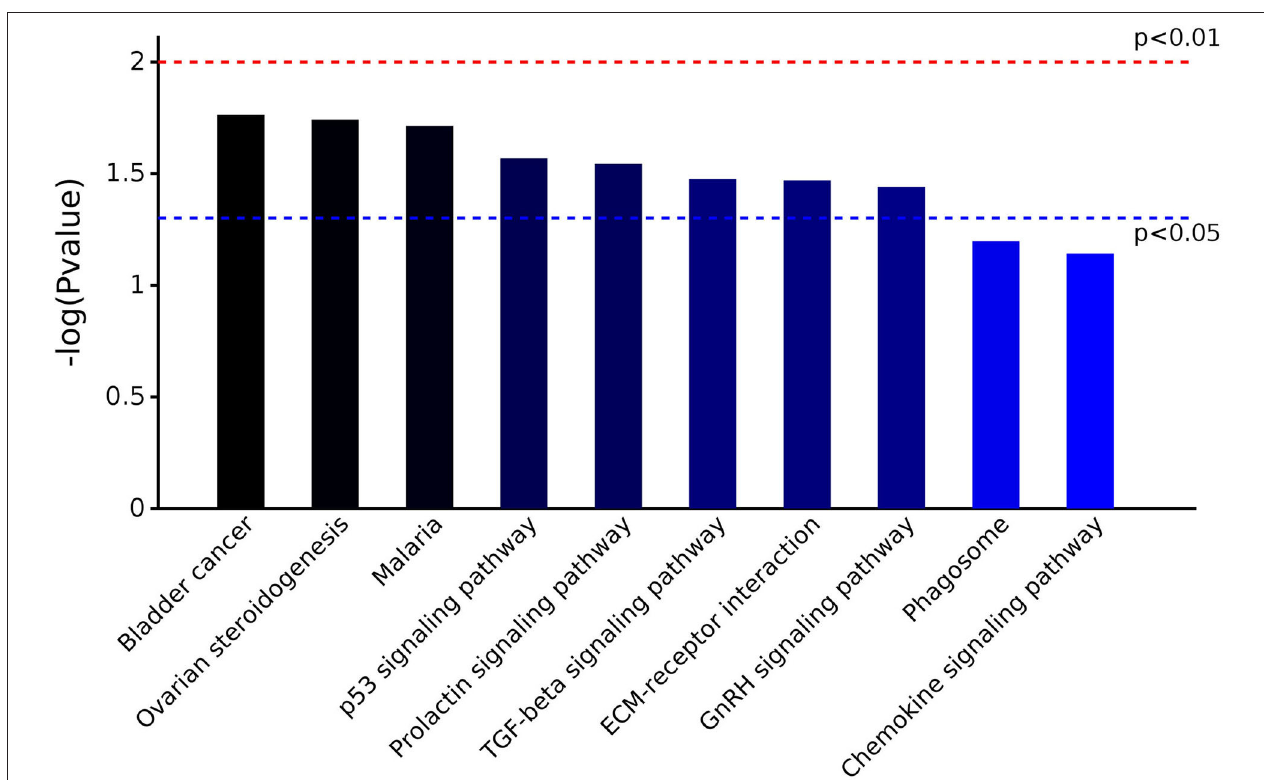
FIGURE 4 | KEGG pathway enrichment analysis of DEPs identified in the serum of early pregnant and non-pregnant jennies.